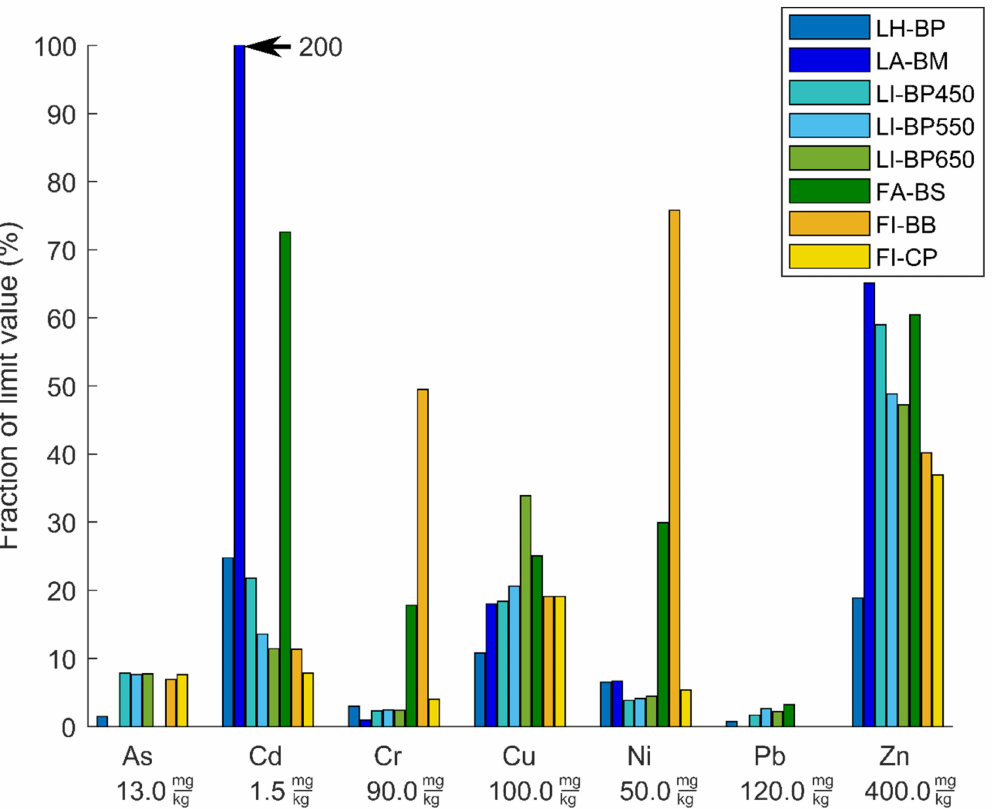
Figure 2. The concentrations of As, Cd, Cr, Cu, Ni, Pb and Zn are presented as percentage of the limit values for agricultural application proposed by the EBC. The EBC limits are indicated on the x -axis labels (mg · kg − 1 ) and set the maximum of 100% on the y